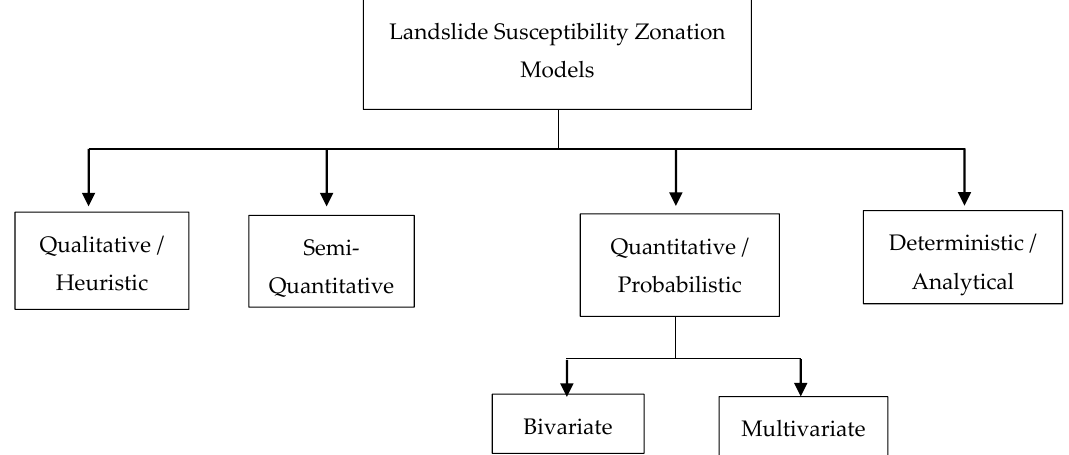
Figure 7. Types of modeling techniques used in landslide susceptibility studies.